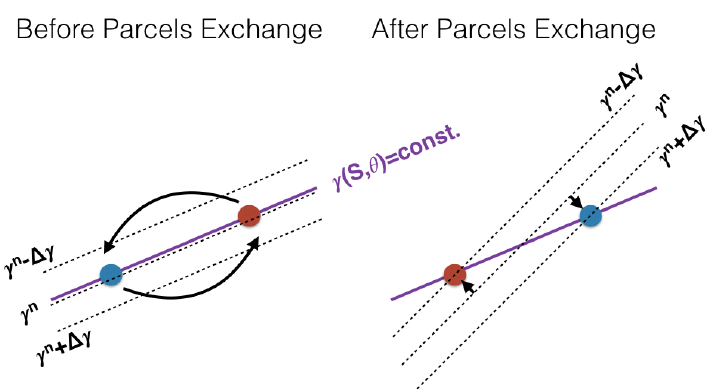
Figure 5. Schematics illustrating the adiabatic vertical dispersion associated with the exchange of two fluid parcels being initially on the same non-material density surface (such as orthobaric density or neutral density for instance, whose iso-surfaces are depicted by the dotted lines). Before the parcel exchange, the non-material density surface coincides with a material density surface γ ( S , θ ) = constant, indicated by the purple solid line, on which the adiabatic and isohaline parcel exchange actually takes place. As the result of the parcels exchange, the density of each parcel changes by ± ∆ γ , resulting in a net mass loss for the original orthobatic or neutral density density class, and a mass gain for the two orthobaric or neutral density surfaces below and above. Since in physical space, the two fluid parcels are supposed to exchange their position, adiabatic and isohaline stirring on orthobaric or neutral density surfaces must result in the latter moving relative to the material iso- γ